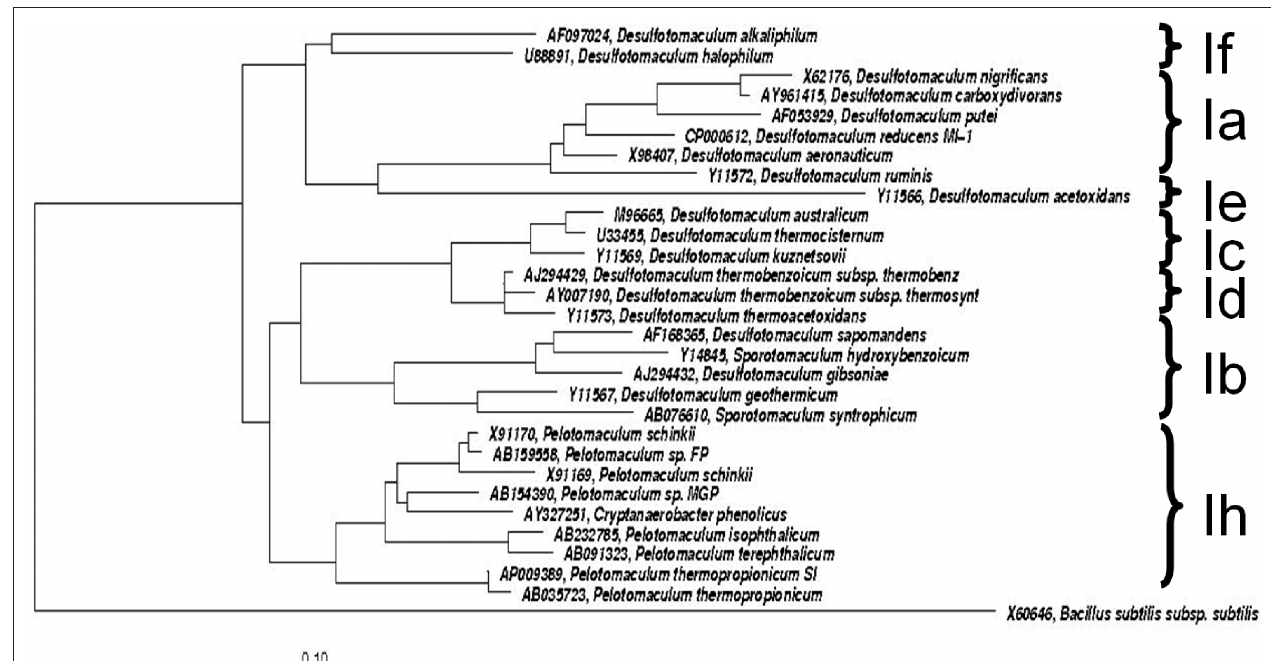
Figure 2 | Phylogenetic tree of Desulfotomaculum cluster i, showing the grouped phylogeny of Pelotomaculum ssp. The tree is based on comparative analyses of 16S rRNA gene sequences. The tree was constructed with